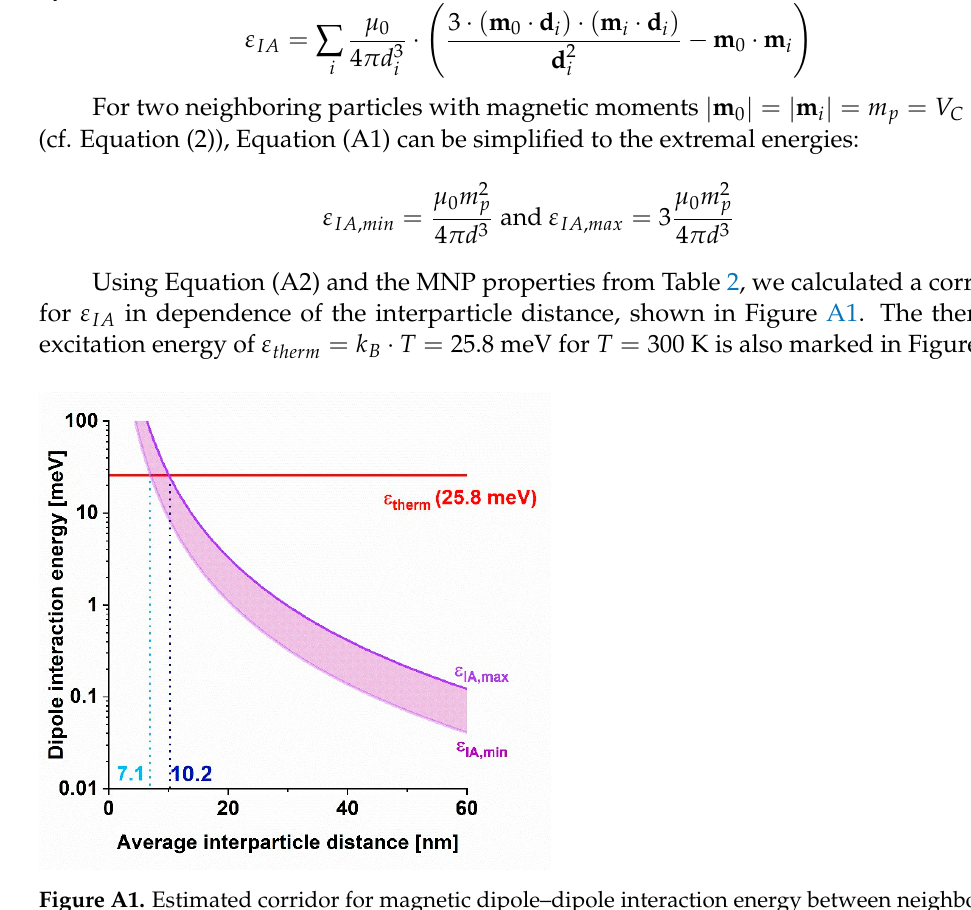
Figure A1. Estimated corridor for magnetic dipole–dipole interaction energy between neighboring MNPs (shaded) versus the average interparticle distance, estimated from Equation (A2). Thermal excitation energy is shown for reference.